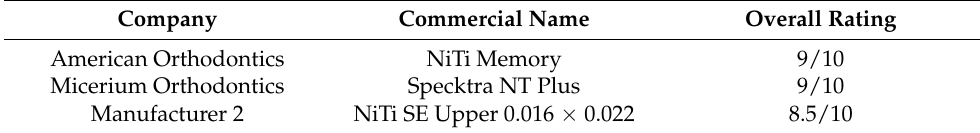
Table 13. Overall rating of NiTi archwires.